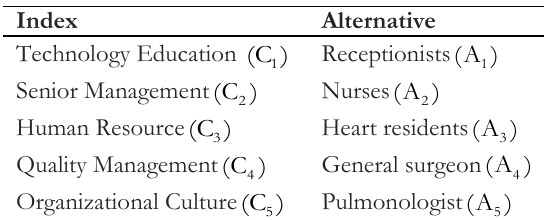
Table 1. Decision matrix.